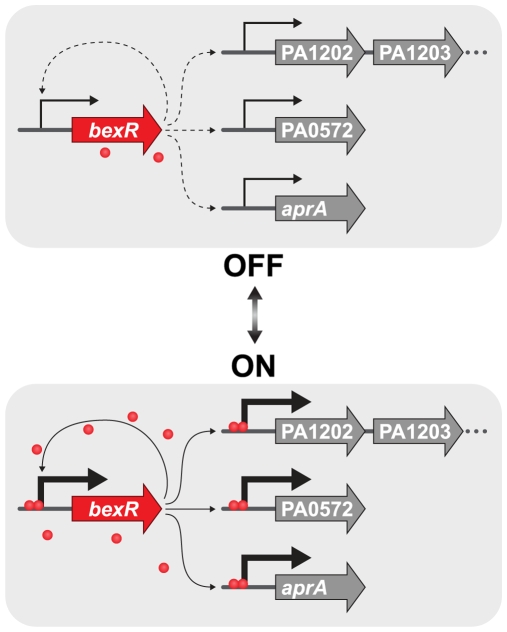
A model for the switch to the ON state.Wild-type P. aeruginosa is hypersensitized to BexR levels by virtue of positive feedback at the bexR locus. Cell-to-cell variability in basal bexR expression results in a stochastically determined subset of cells activating the positive autoregulatory loop by BexR binding to its own promoter and activating transcription. At this point, the ON state is maintained by direct positive feedback. Transcription of downstream genes such as aprA, PA0572, and the PA1202 operon is upregulated in the ON state by BexR binding to their promoters and activating transcription.